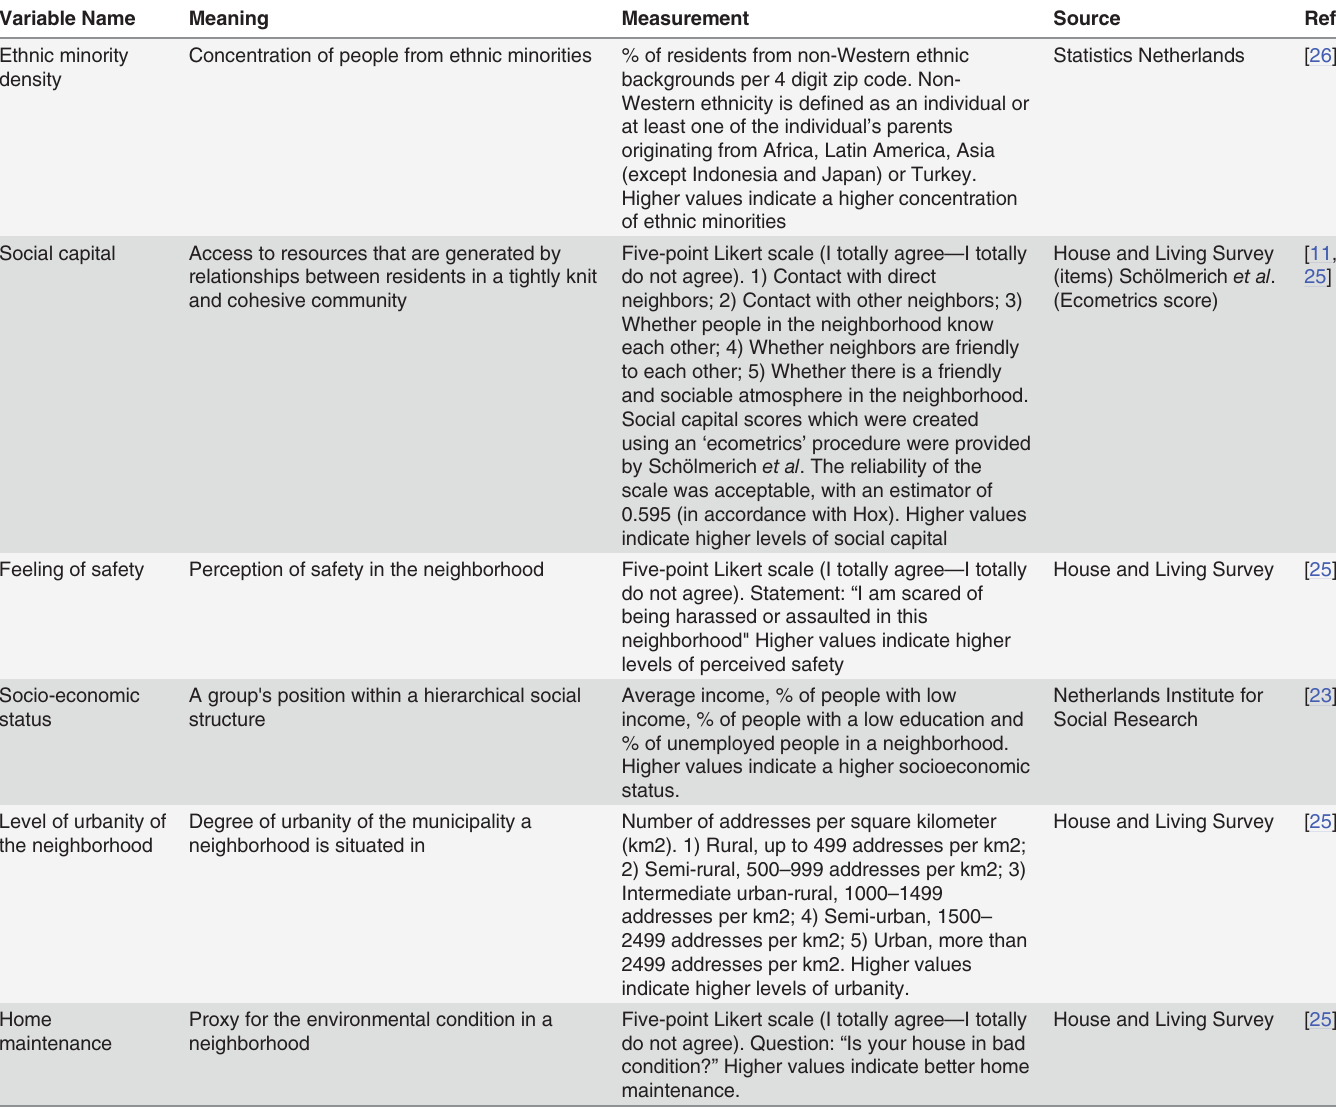
Table 1. Detailed description of neighborhood level variables included in the multilevel